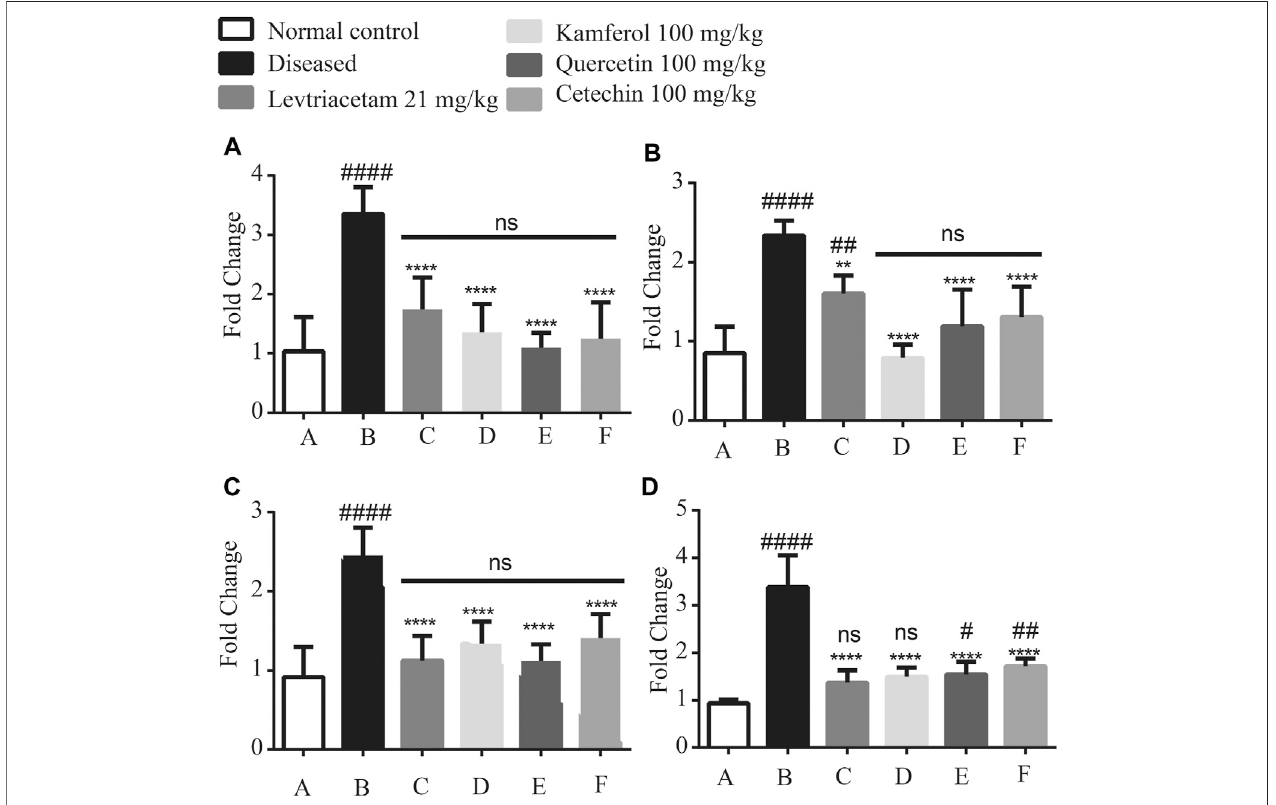
FIGURE7| Graphicalrepresentationofthemean ± SDrelativeexpressionlevelsof (A) TNF- α , (B) IL-6, (C) IL1beta,and (D) NFkB.ThetreatmentofPFsigni fi cantly suppressesthepro-in fl ammatorycytokines.Thedatawereanalyzedbyone-wayANOVAfollowedbyTukey ’ s posthoc test.ComparisonofGroupAvsB,C,D,E,andF denoted by (#), while Group B vs C, D, E, and F is denoted by (*). * p < 0.05. ** p < 0.01, *** p < 0.0005, and **** p < 0.0001.